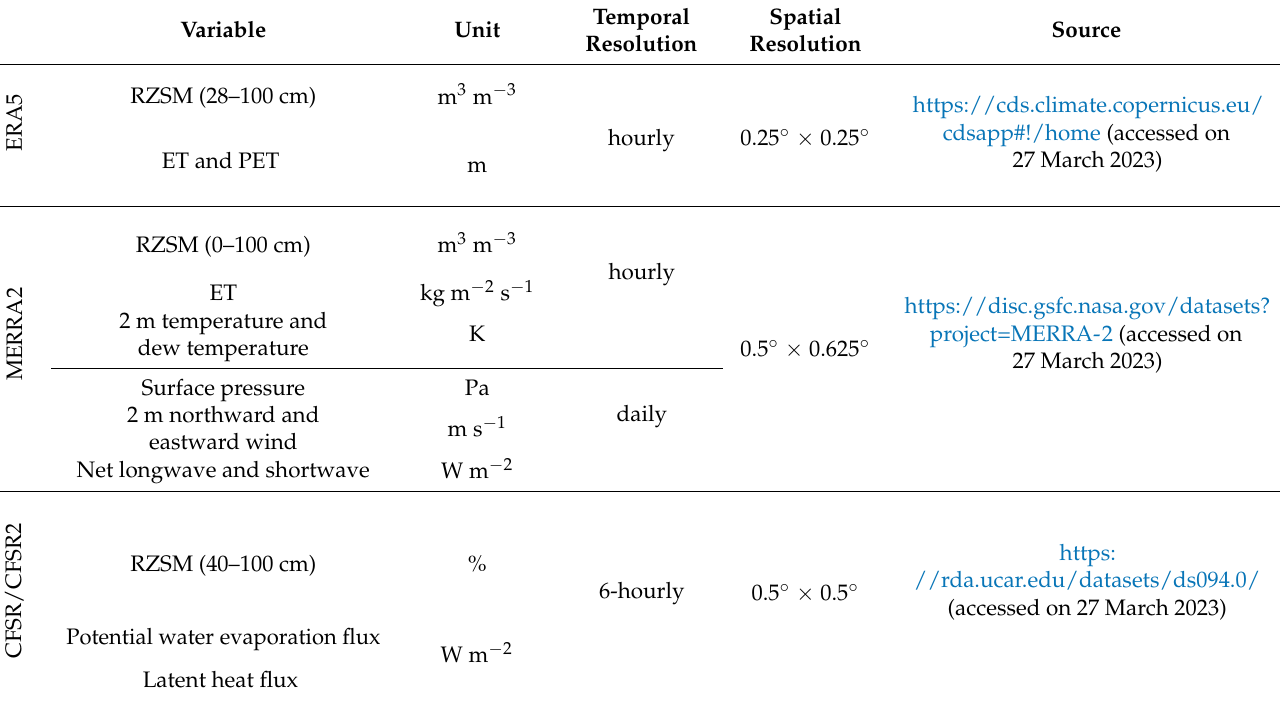
Table 1. The detail of reanalysis data used in the